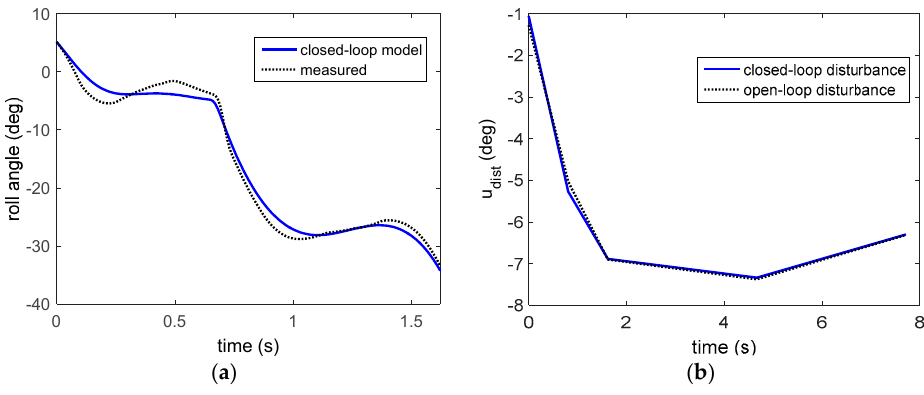
Figure 22. ( a ) Roll angle closed loop response versus data; ( b ) Identified disturbance comparison.